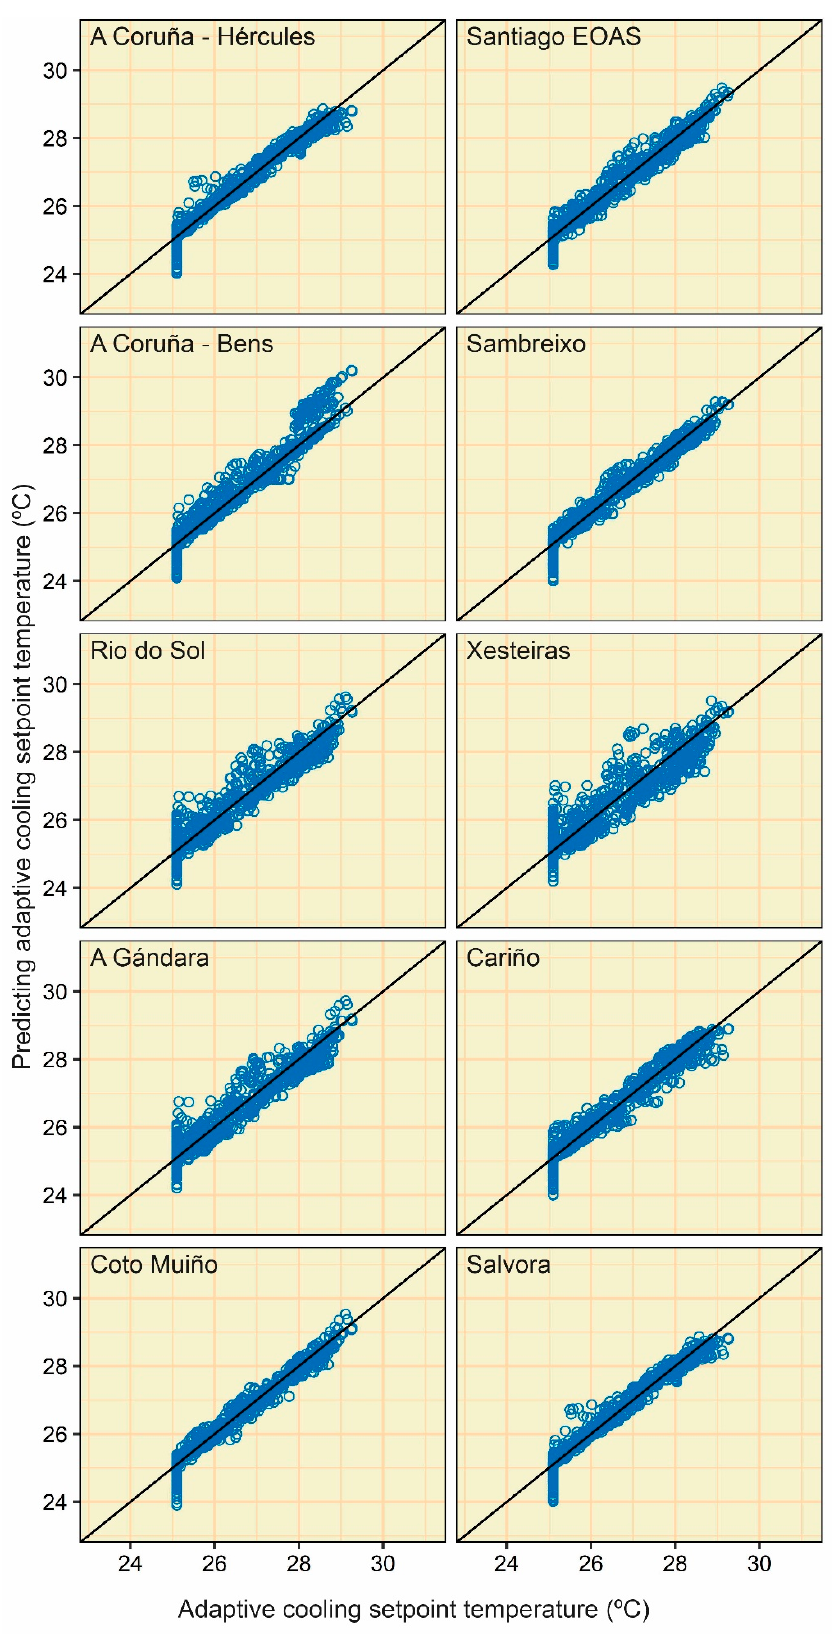
Figure A8. Point clouds between the actual and predicting adaptive cooling setpoint temperature values (category II) of the MLR (approach 2).